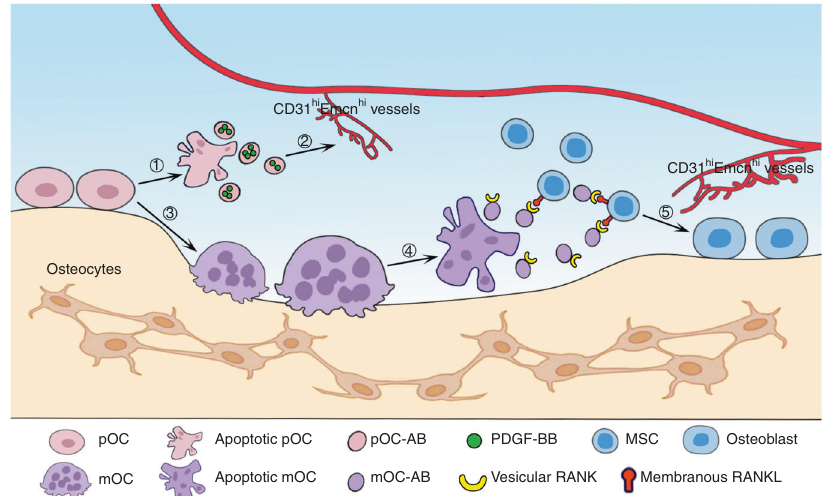
Fig. 7 Schematic diagram showing the role of osteoclast-derived ABs in bridging bone resorption and formation in bone remodeling. ① A fraction of pOCs undergo apoptosis and secrete pOC-ABs. ② pOC-ABs induce the formation of CD31 hi Emcn hi vessels by delivering PDGF-BB to recipient EPCs. ③ pOCs differentiate into mOCs upon stimulation with RANKL and M-CSF. ④ mOCs undergo apoptosis and secrete mOC-ABs at the end of the bone resorption phase. ⑤ mOC-ABs promote osteogenesis through RANKL reverse signaling. In addition, CD31 hi Emcn hi vessels induced by pOC-ABs improve local nutrient and metabolic waste transport to further maintain the integrity of bone